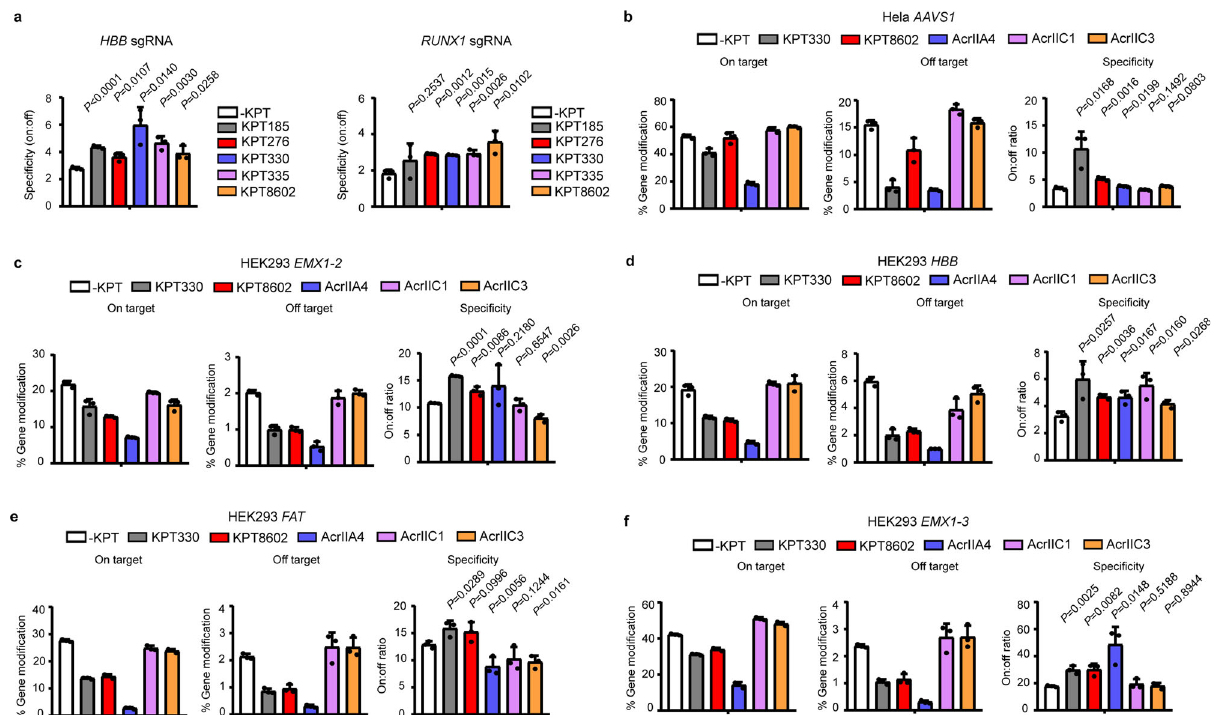
Fig. 3 Evaluation of the effects of SINEs on the genome-editing speci fi city of CRISPR-Cas9. a SINEs at 0.5 μ M improve the genome-editing speci fi city of CRISPR-Cas9 at HBB gene and RUNX1 in HEK293 cells. b Comparison of the effects of SINEs and Acrs on the genome-editing activity of CRISPR-Cas9 at AAVS1 site in Hela cells. c – f Comparison of the effects of SINEs and Acrs on the genome-editing activity of CRISPR-Cas9 at EMX1-2 , HBB , FAT , and EMX1-3 in HEK293 cells. The data are shown as mean ± SD ( n = 3 biologically independent samples) and the signi fi cant difference between mock and SINE or Acrs treatment is determined using Student ’ s t